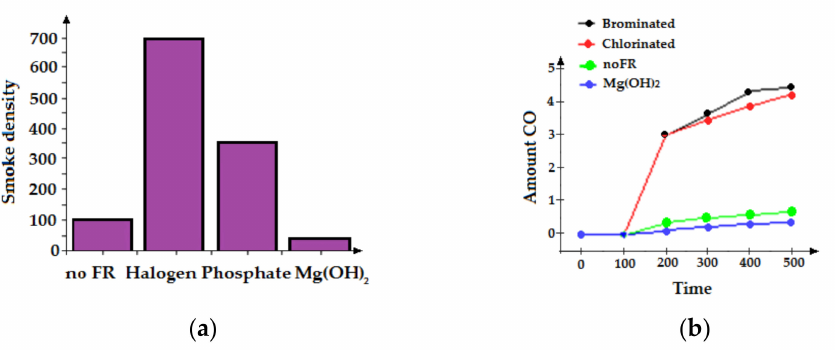
Figure 6. ( a ) Smoke density and ( b ) CO amounts of PP compounds with different flame